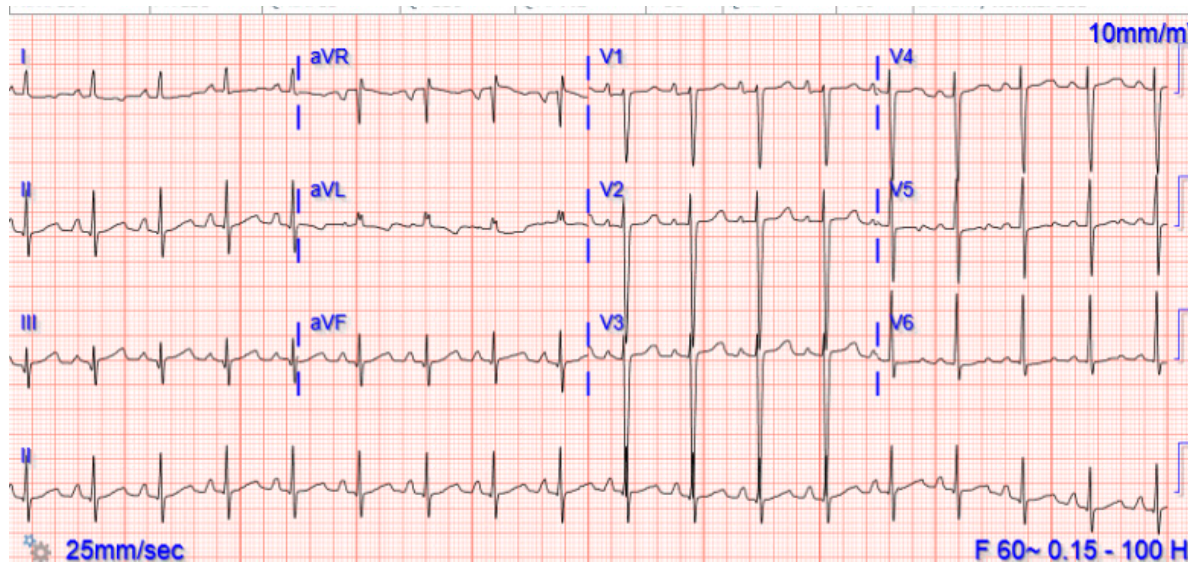
Figure 1. Sinus rhythm with sinus tachycardia.